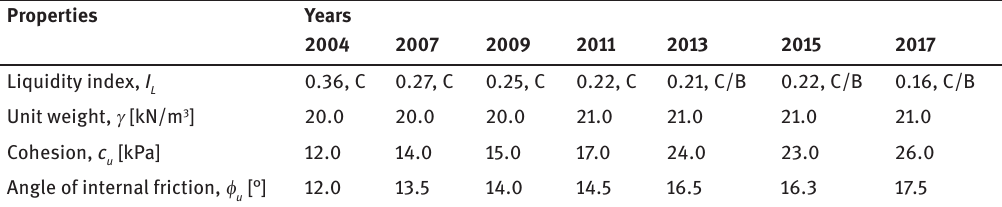
Table 2 : Retaining embankment soil parameters by liquidity index I Properties